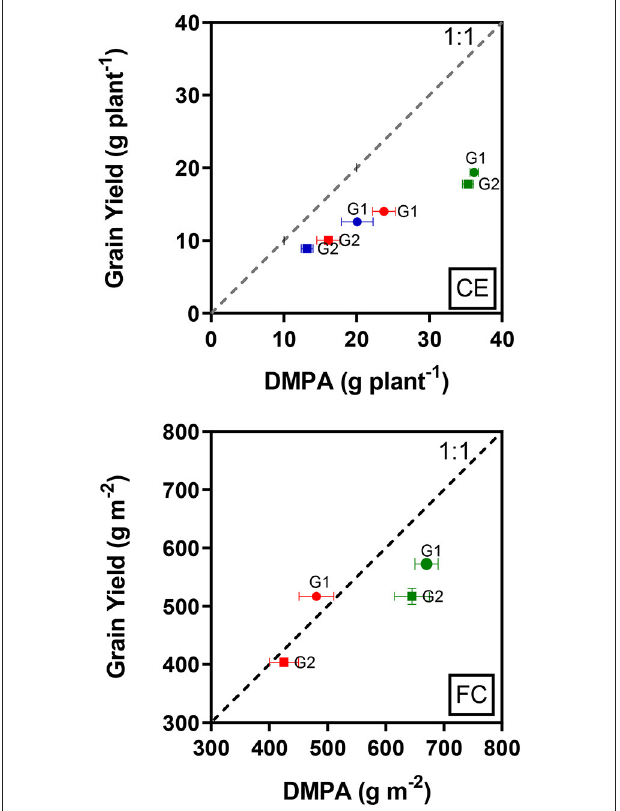
FIGURE 1 | Relationship between mean grain yield and dry biomass produced after anthesis (DMPA) in the two wheat genotypes (G1, putative heat tolerant and G2, putative heat susceptible) in response to day/night temperatures of CET1 [control (22/14 ◦ C), green symbols], CET2 (30/20 ◦ C from heading, blue symbols), and CET3 (30/20 ◦ C from anthesis, red symbols) under controlled environment conditions (CE) or field chamber (FC) conditions (FCT1, ambient temperature chamber, green symbols; FCT2, heated chamber, red symbols). The dashed line represents 1:1 and error bars represent ± 1